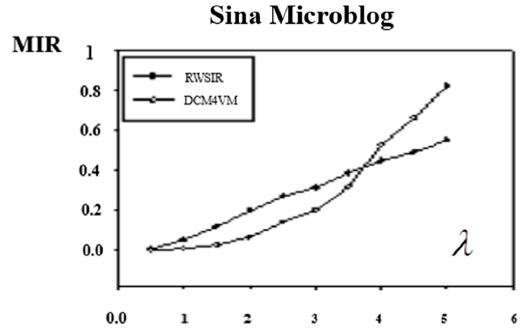
Figure 4. Comparison in maximum infection rate (MIR).